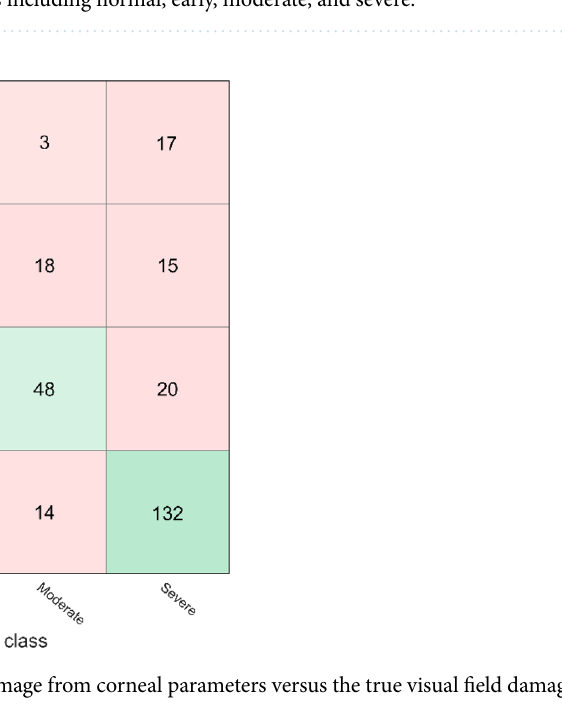
Figure 5. Receiver operating characteristic (ROC) curve of ensemble machine learning bagged trees model for detecting four visual field severity levels including normal, early, moderate, and severe.